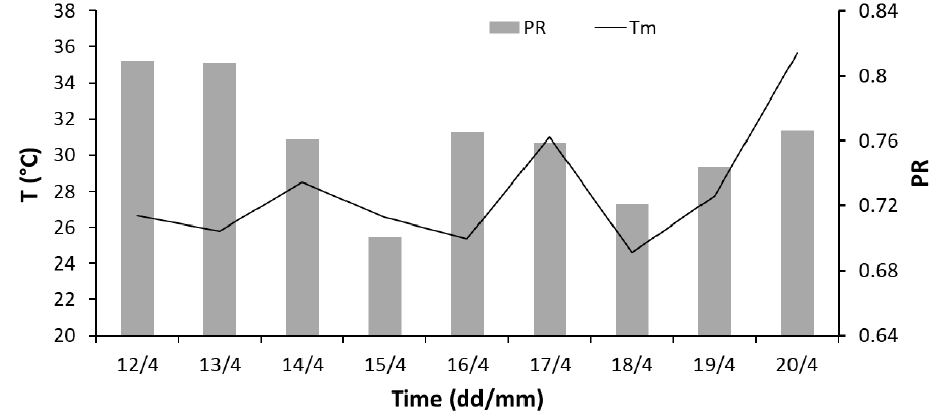
Figure 14. Daily PR , and diurnal average module temperature of DSM during the days of test.